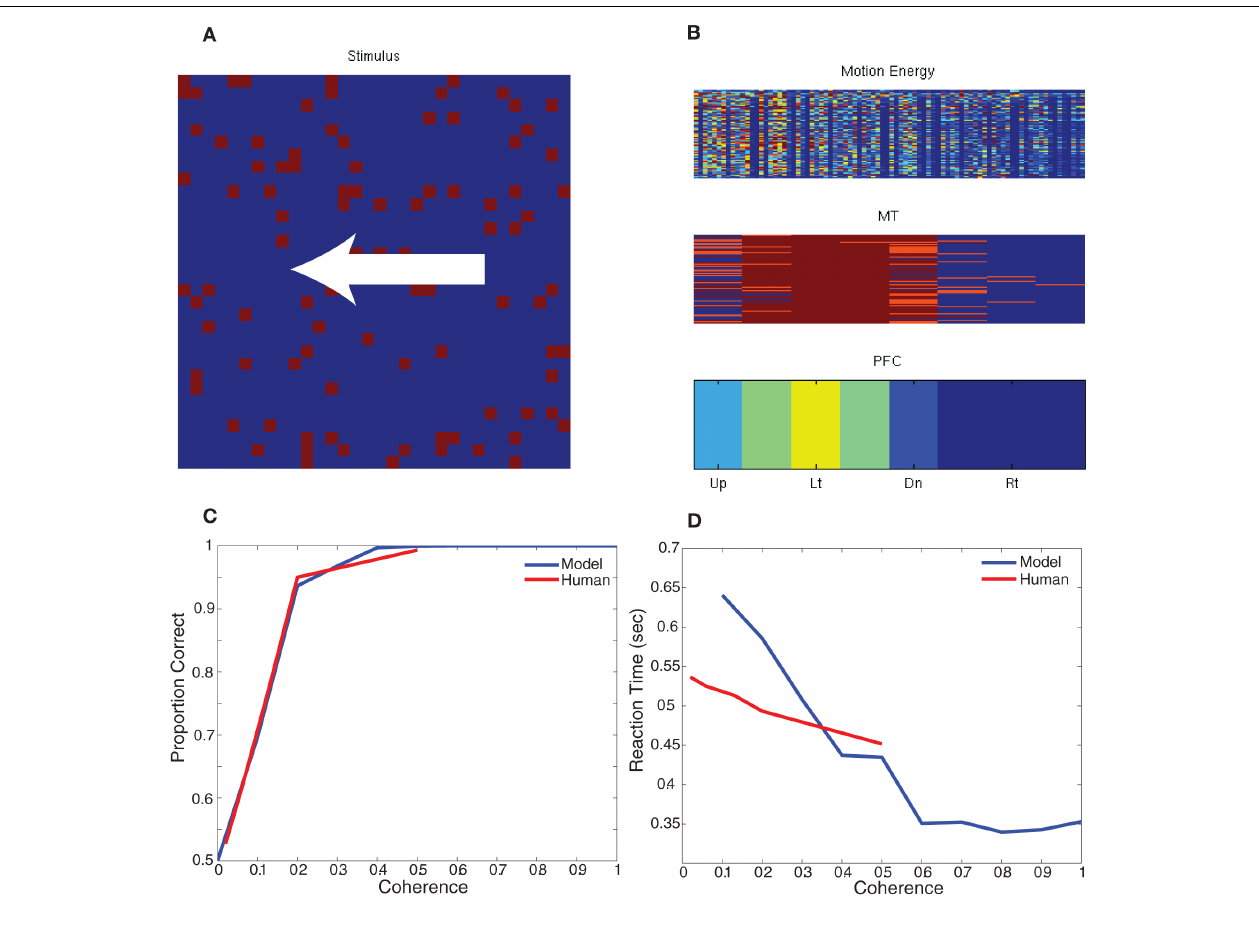
(PFC) clearly show that the unit corresponding to leftward motion is responding maximally. (C,D) Comparison of the network response and human data for different levels of coherence dot movement. (C) Correct decision-making as a function of motion coherence. (D) Reaction time as a function of motion coherence. Human psychophysical data was adapted from (Resulaj et al.,